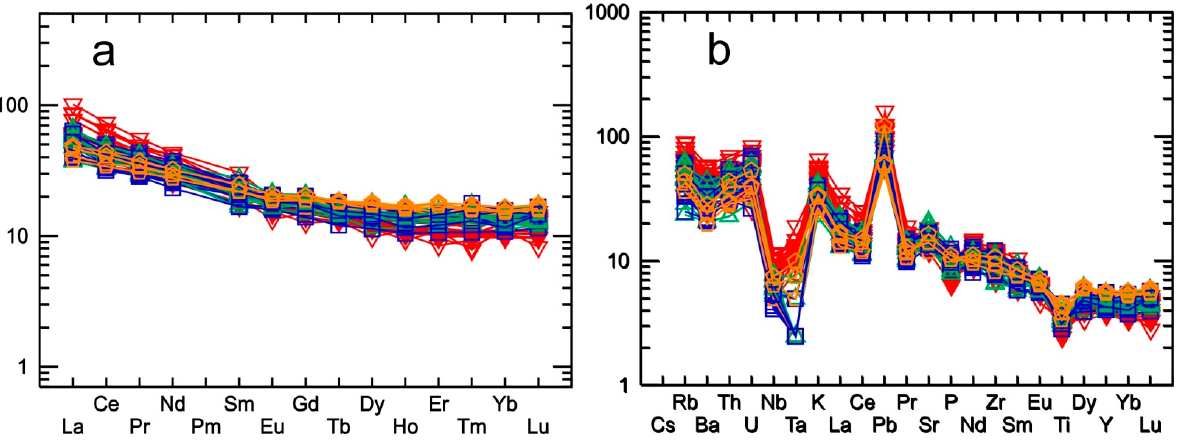
Figure 11. ( a ) CI Chondrite-normalized REE diagrams and ( b ) primitive mantle-normalized multielement diagrams for the analyzed igneous rocks of the Bont ă u volcanic complex and Group 1-Z rocks [3]. Symbols and source of the data as in Figure 9. The normalizing values are from [51]. Twelve new Sr and Nd isotope analyses (Supplementary Tables S1) show the initial 87 Sr/ 86 Sr and 143 Nd/ 144 Nd ratios of the Bont ă u volcanics varying in minor ranges, the most primitive for the basaltic andesites (0.7044 and 0.5127), then slightly higher for the andesites (0.7044–0.7054 and 0.5127–0.5125) showing a trend toward a 87 Sr/ 86 Sr increase and a 143 Nd/ 144 Nd decrease toward EM II (Figure 12). There are no essential differences between separated symbols. Highest Sr and Nd values correspond to the measured samples collected from DADs and are representative for amphibole (±pyroxene) andesitic compositions. The isotopic values fall in the field of the calc-alkaline basalts in the Carpathian-Pannonian Region [22]. The most primitive rocks of the Bont ă u volcanics show similar isotopic values as Group 1.2-S, Group 2-N, and Group 3-S of [3], making it evident that Apuseni magmas are isotopically the most primitive in the Carpathian- Pannonian Region (e.g., [22]). The range of new data of the Bont ă u volcanics, some more primitive, fits in the trend of the previous data of Group 1-Z, suggestive of assimilation- fractional crystallization (AFC) processes. Figure 12. Isotopic characteristics of Bont ă u volcanic complex relative to the mantle components defined by [52] and the European Asthenospheric Reservoir (EAR) defined in [53,54]. Symbols and source of the data as in Figure 9. CAB defines the field of the calc-alkaline basalts in the Carpathian Pannonian Region after [22]. Data of the Groups 1-Z, 1.2-S, 2-N, and 3-S from [3].